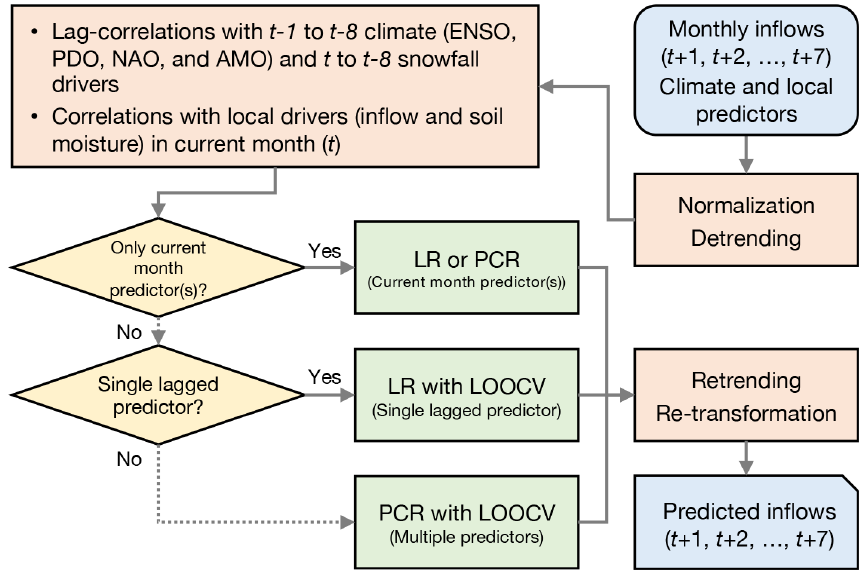
Figure 1. Graphical representation of the monthly prediction (MP) model scheme. At each calendar month t , we develop seven independent models to predict monthly inflows for the next 7 months: MP1 ( t + 1), MP2 ( t + 2), ... , MP7 ( t +